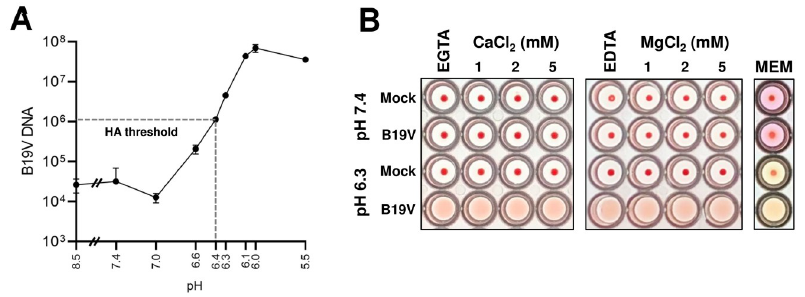
Fig 4. Determination of the optimal conditions required for B19V and Gb4 interaction. (A) Determination of the optimal pH for B19V binding to Gb4. RBCs (0.5% in 100 μ l PiBS) were incubated with B19V (5x10 9 ) at pH values ranging from 8.5 to 5.5. After 1h, cells were washed in the corresponding buffer, and viral DNA was extracted and quantified by qPCR. (B) Hemagglutination at neutral (7.4) or acidic (6.3) pH was carried out in the presence of divalent cations (Ca 2+ or Mg 2+ ), chelating agents (5 mM EGTA or EDTA) or in minimal essential medium (MEM). B19V was incubated with the different buffers for 1h before incubation with the erythrocytes. HA, hemagglutination